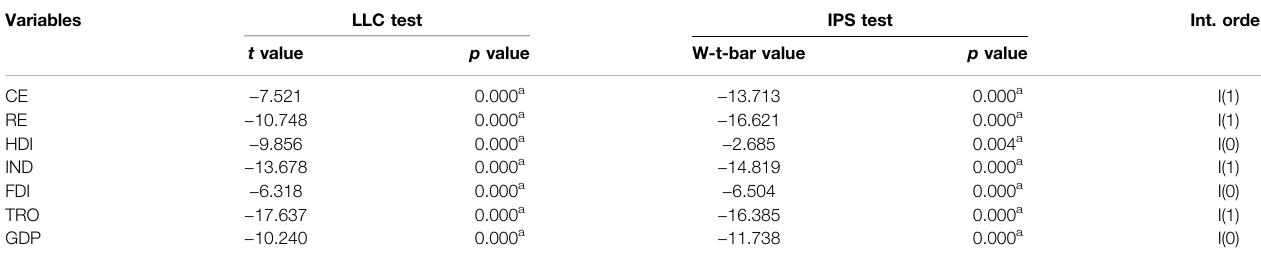
TABLE 3 | Test result of panel unit root-High income countries.